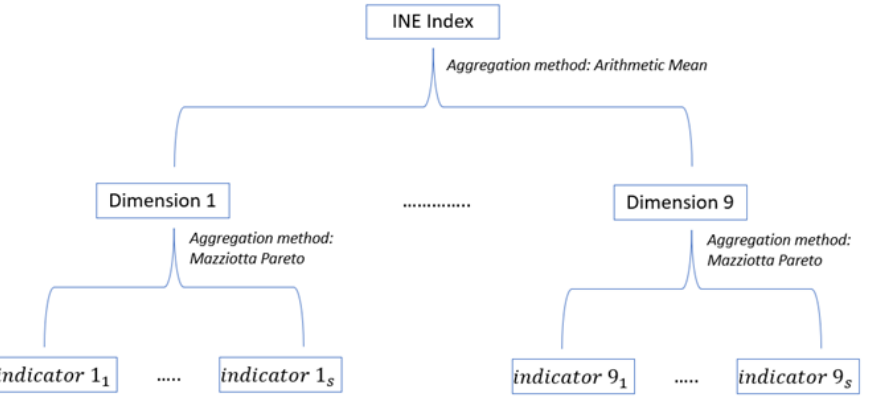
Figure 1. The indicators that define each of the nine